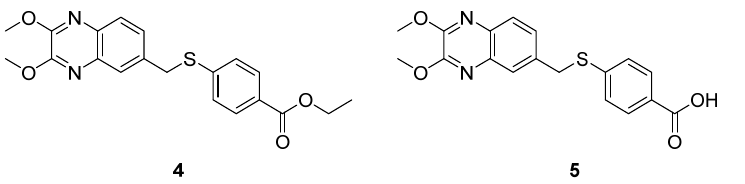
Figure 6. Chemical structures of compounds 4 and 5 .